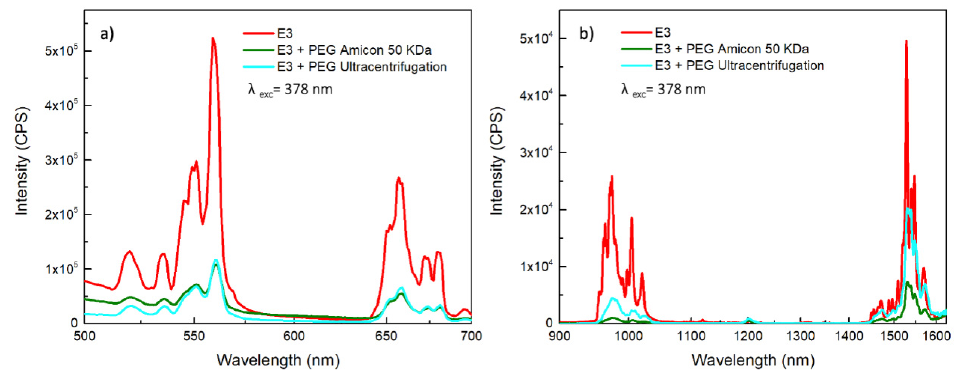
Figure 6. PL emission spectra in the visible ( a ) and IR ( b ) range of Er:Y 2 O 3 NPs sample E3 core and pegylated core/shell after purification ( λ exc = 378 nm).